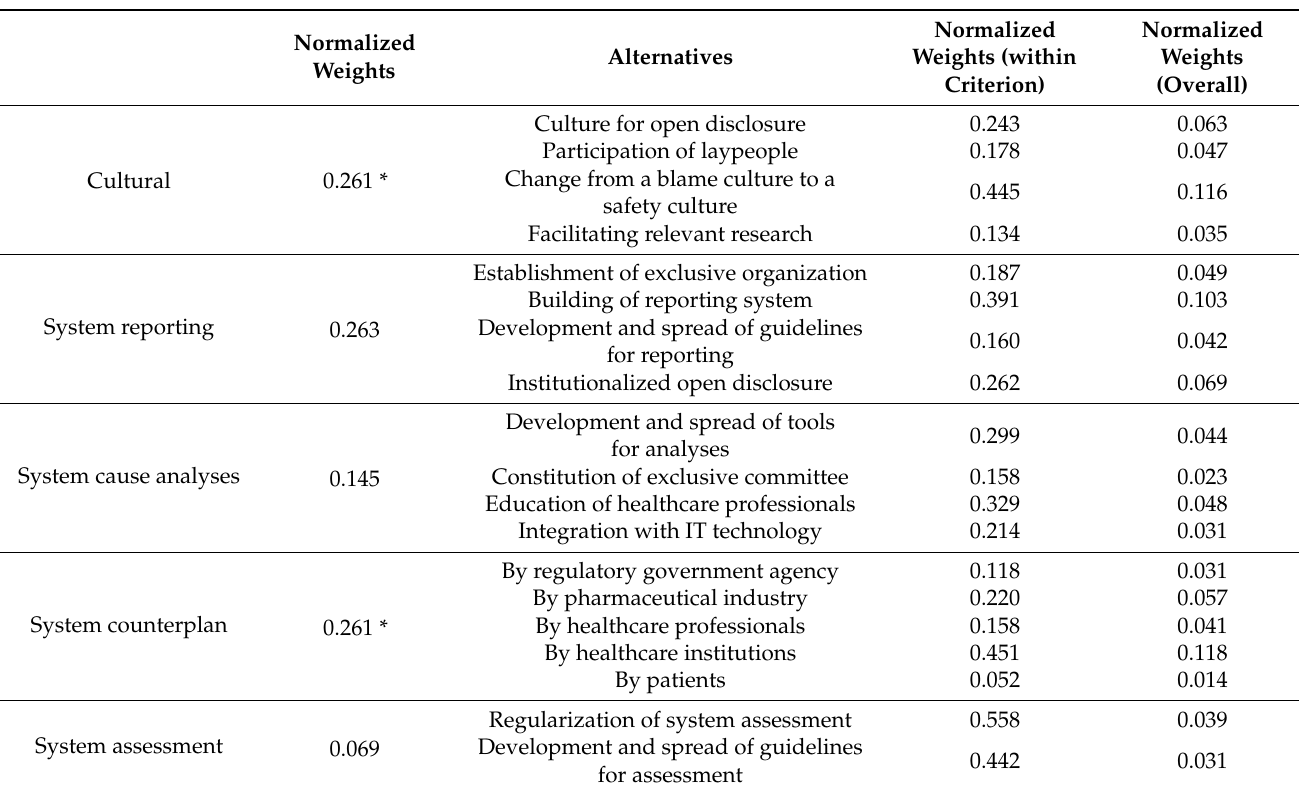
Table 4. Normalized weights of